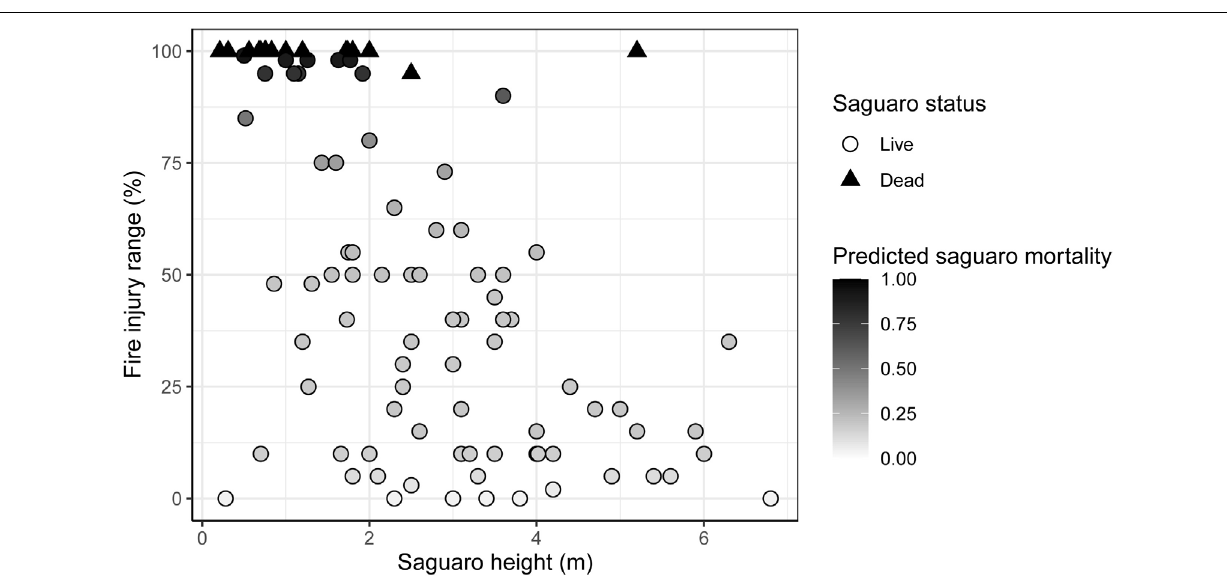
FIGURE 5 | Impacts of fire on saguaros ( Carnegiea gigantea ). The relationship between individual saguaro height and the range of injury by the Mercer Fire. Dead saguaros are shown in black triangles, live saguaros are shown in circles with the grayscale gradient indicating future mortality probability of each saguaro based on the range of fire